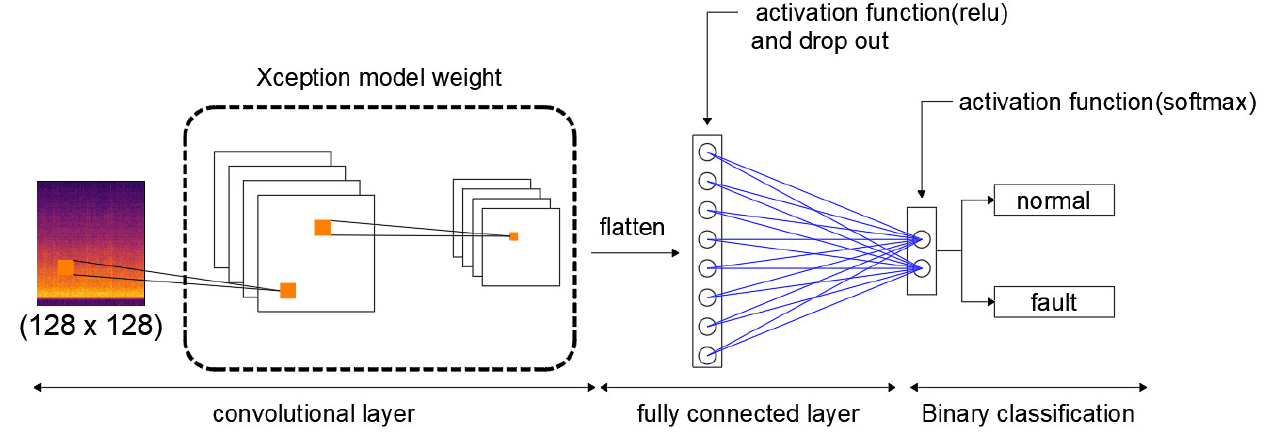
Figure 9. Binary classifier based on Xception model.